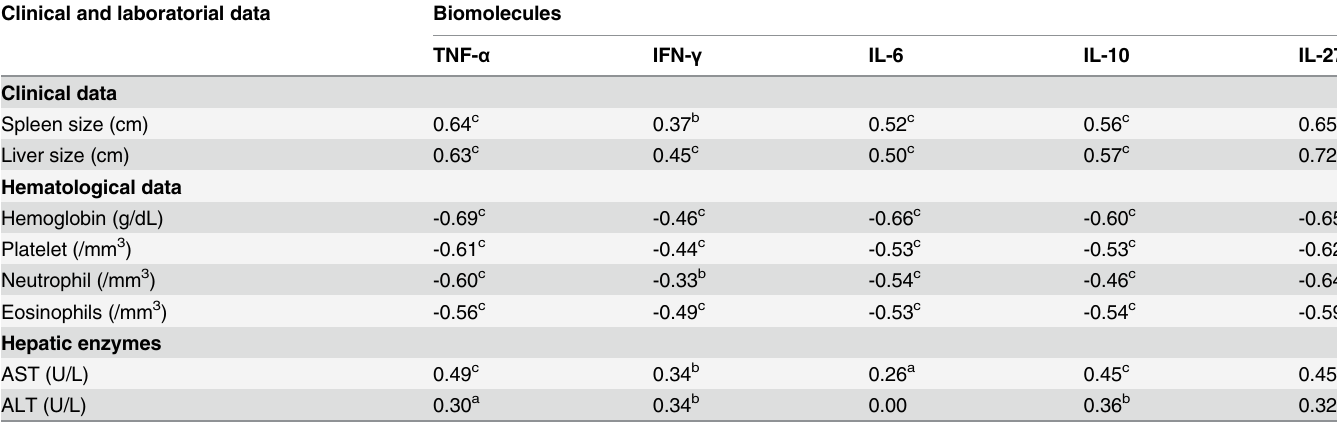
Table 2. Correlation between serum cytokine levels, and clinical and hematological data of the all